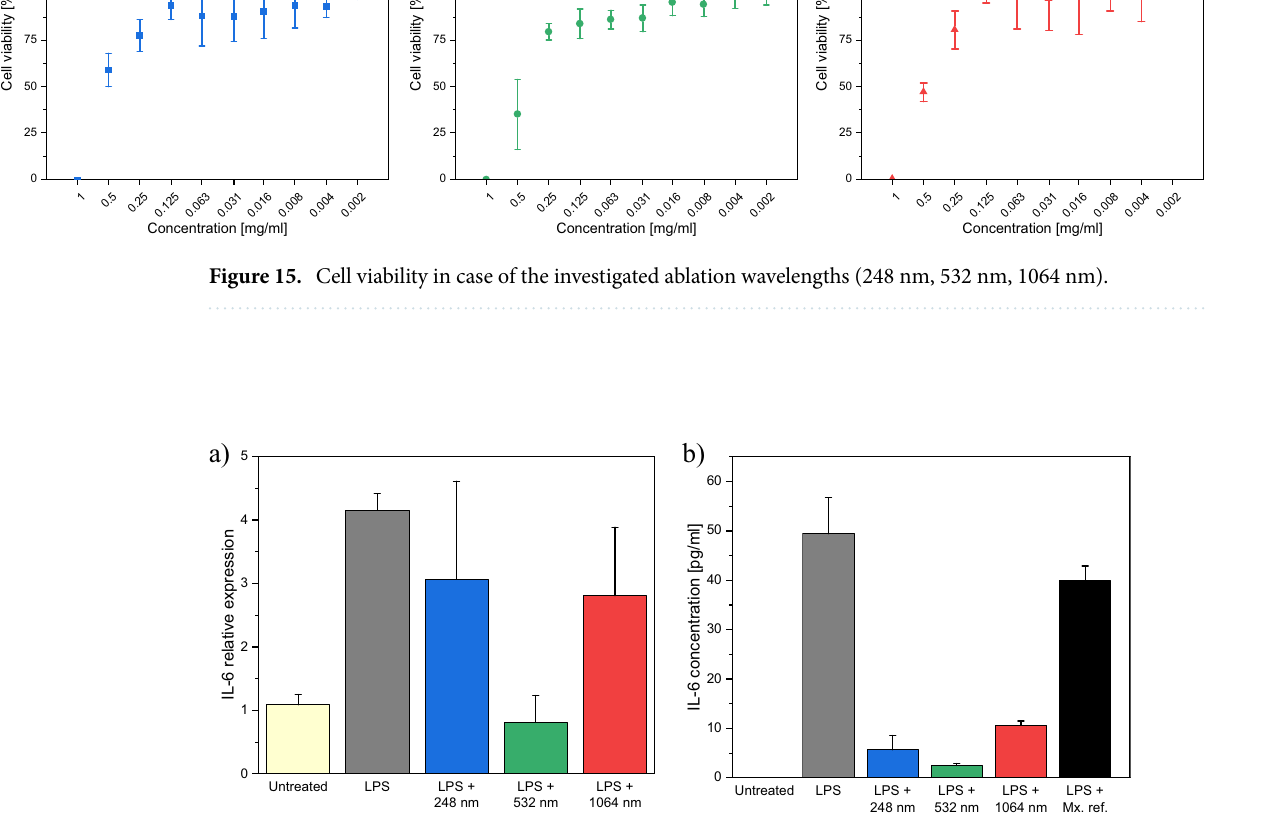
Figure 16. (a) Relative expression and (b) concentration of IL-6 in case of untreated A549 cells (Untreated), LPS-treated A549 cells (LPS), A549 cells treated with LPS and meloxicam suspension generated by laser ablation at respective wavelengths (LPS + 248 nm, LPS + 532 nm and LPS + 1064 nm). In case of the IL-6 concentration ( b ), the data of A549 cells treated with LPS and reference meloxicam suspension (LPS + Mx. ref.) is also